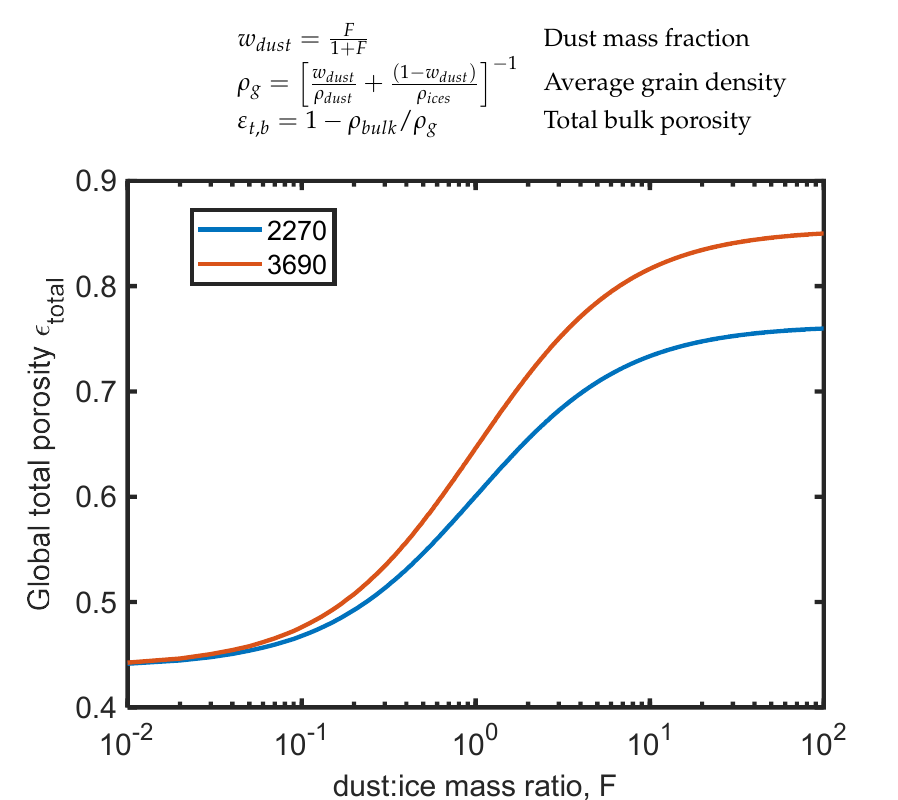
Figure 6. Global, total porosity of comet 67P vs. dust:ice mass ratio F. Parameter is the dust grain density in kgm −3 , i.e., the bounds of carbonaceous chondrite meteorites from [58]. The density of ice (actually a mix of various frozen volatiles after [60]) is assumed as (957.5 ± 4.5) kgm −3 and the global average bulk density as (537.8 ± 0.6) kg m −3 [57]; microporosity of both dust and ice is assumed to be 0. The dust:ice ratio in the nucleus is still debated (see main text).